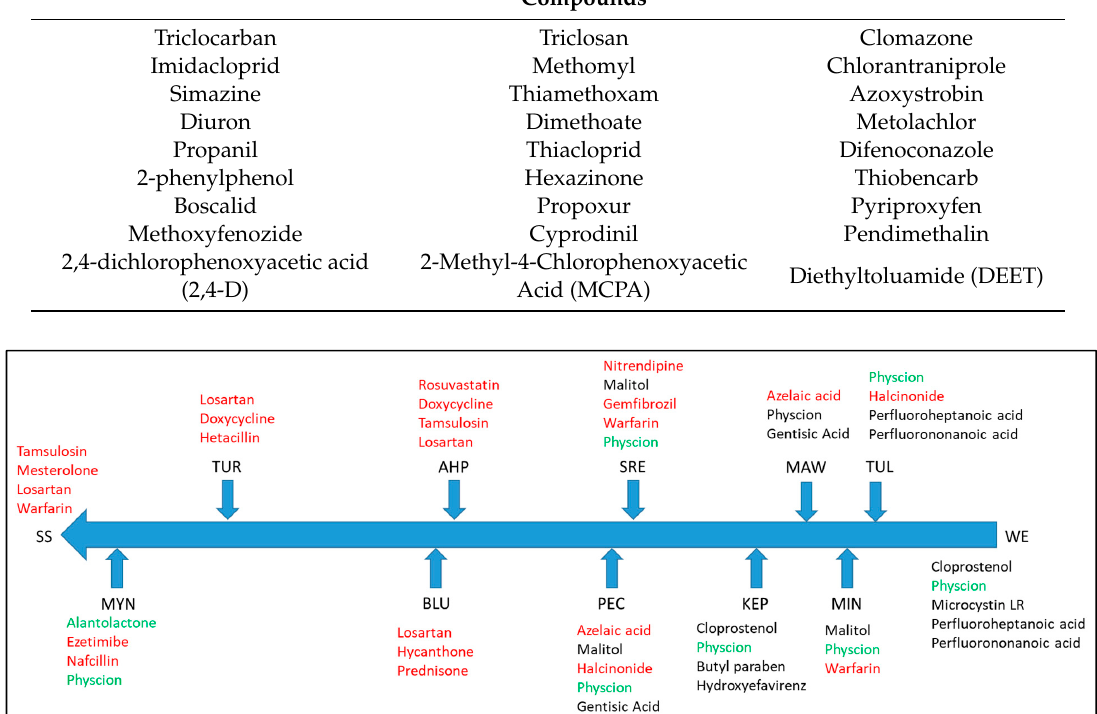
Figure 3. Suspect screening results for LC-Q/TOF-MS data.